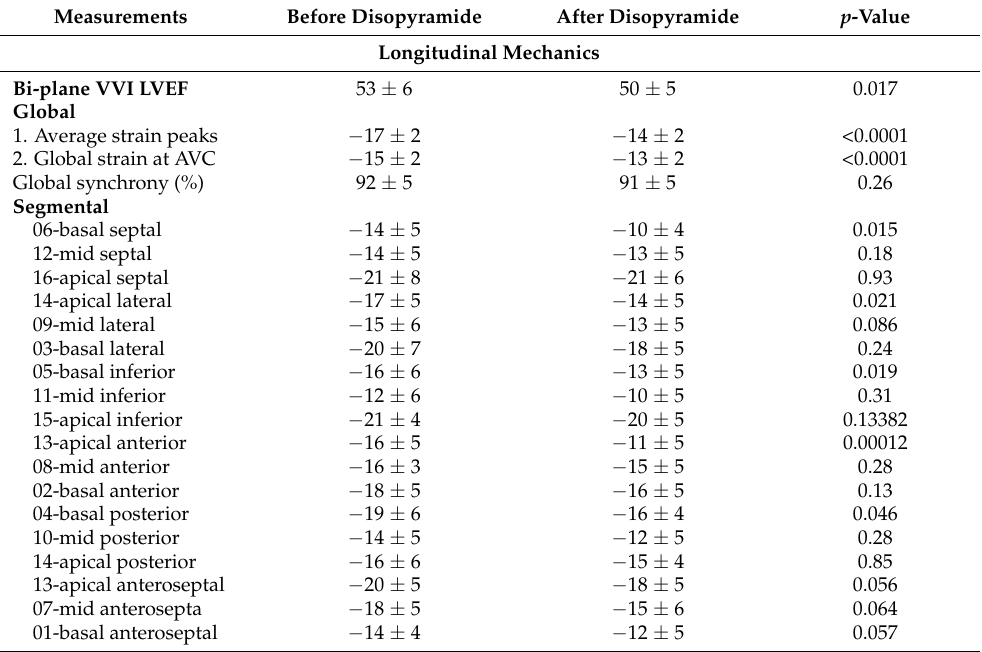
Table 2. Longitudinal and circumferential strain results (%) in 19 patients with HOCM (mean ± SD). Measurements Before